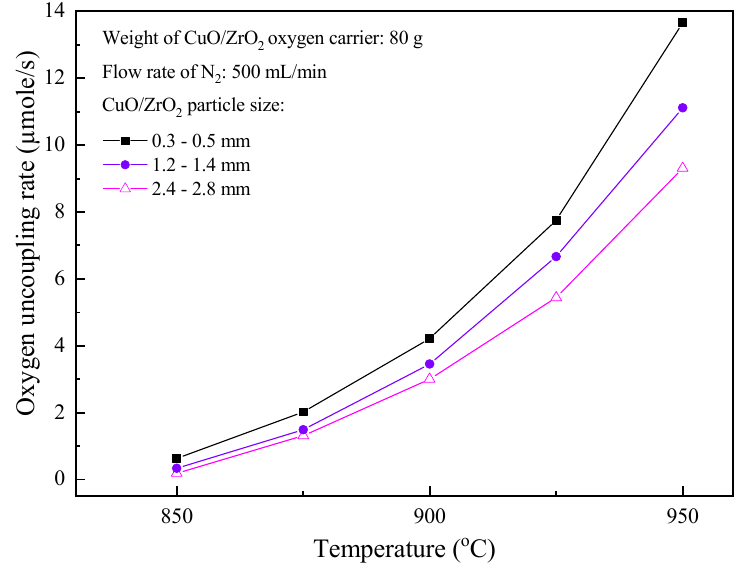
Figure 5. Oxygen uncoupling rate for CZ230-S1 of various particle sizes operated at temperature